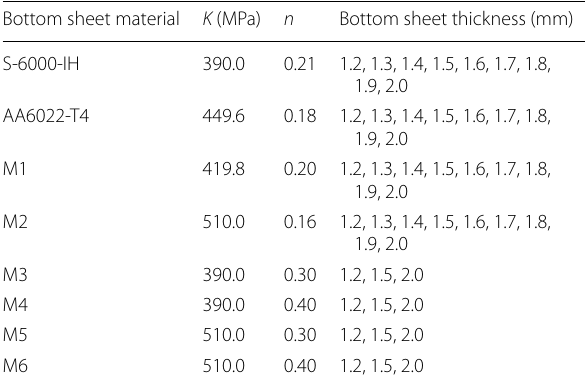
Table 5 Hollomon model parameters and thickness of bottom sheet material used in the simulation Bottom sheet material K (MPa) n Bottom sheet thickness (mm)